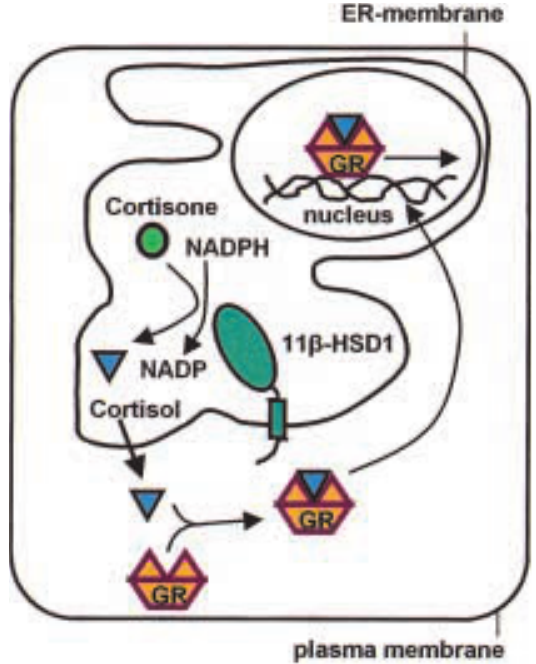
Local activation of the glucocorticoid receptor. 11 b -HSD1 converts the inactive 11-ketoglucocorticoid cortisone to the ac- tive 11 b -hydroxyglu- cocorticoid cortisol and controls the local activation of the GR. Upon binding of cor- tisol, the GR trans- locates into the nu- cleus where it regu- lates the transcrip- tion of a variety of